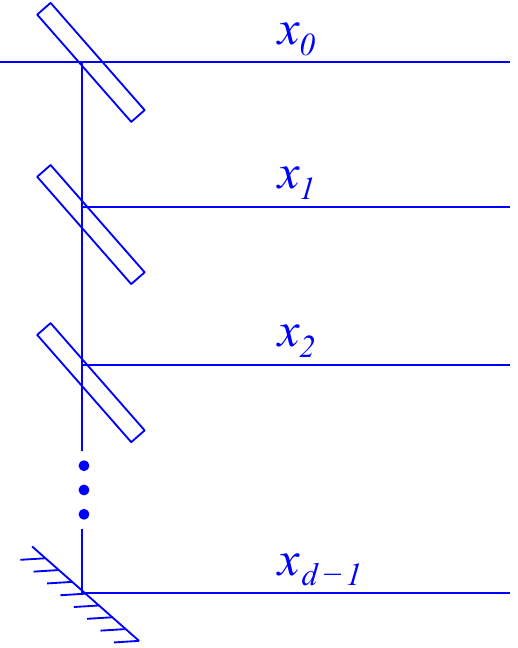
Figure 12: One way of instantiating d spatial modes in an interferometer. A single photon is passed through the first beamsplitter from the left and is repeatedly split at d − 1 beam- splitters, with the ( d − 1) th mode reflected by the mirror at the